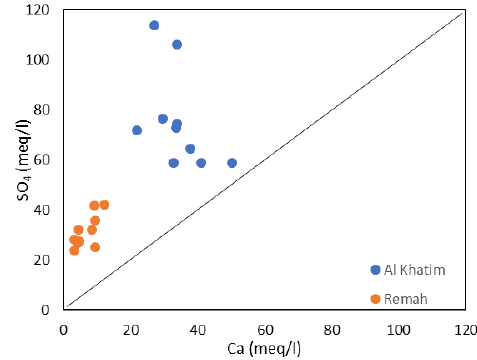
Figure 15. Ca versus SO 4 plot for Remah and Al Khatim.